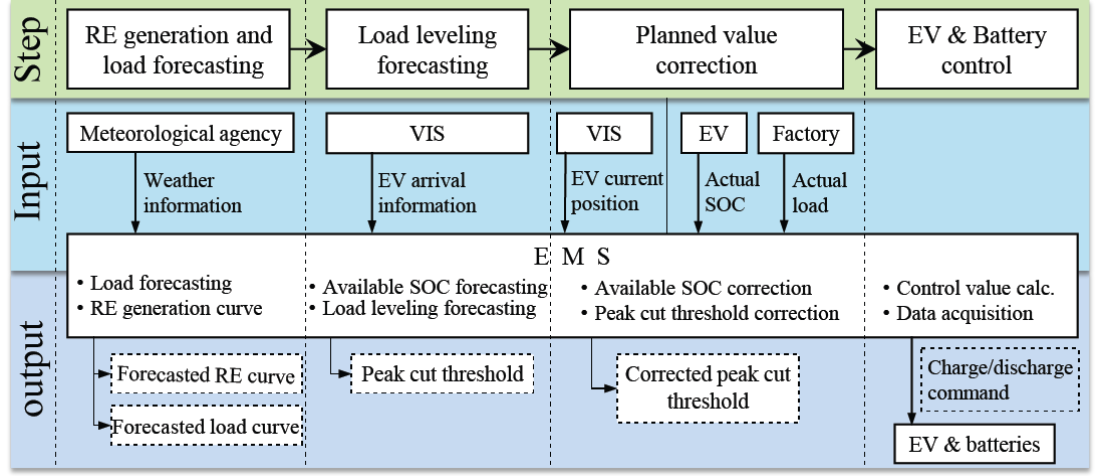
Figure 6. Basic concept of developed load leveling in a small-scale EMS involving EVs and their used